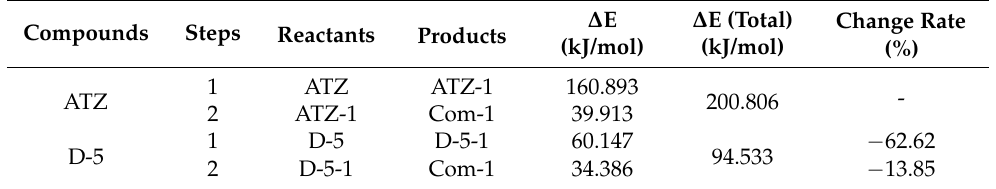
Table 3. Calculation of reaction energy barrier and change rates of the microbial degradation of ATZ and substitute D-5 in Stage